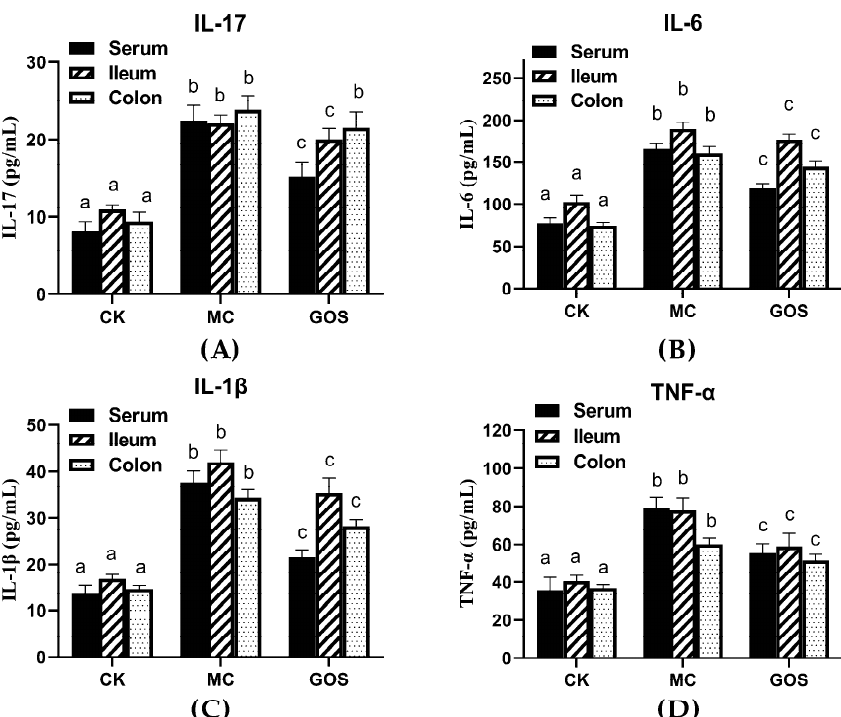
Figure 3. The concentration of inflammatory factors in di ff erent tissues. ( A ) The concentration of IL-17; ( B ) The concentration of IL-6; ( C ) The concentration of IL-1 β ; ( D ) The concentration of TNF- α . Di ff erent letters (a–c) showed significant di ff erences ( p < 0.05) in the same tissues among groups.